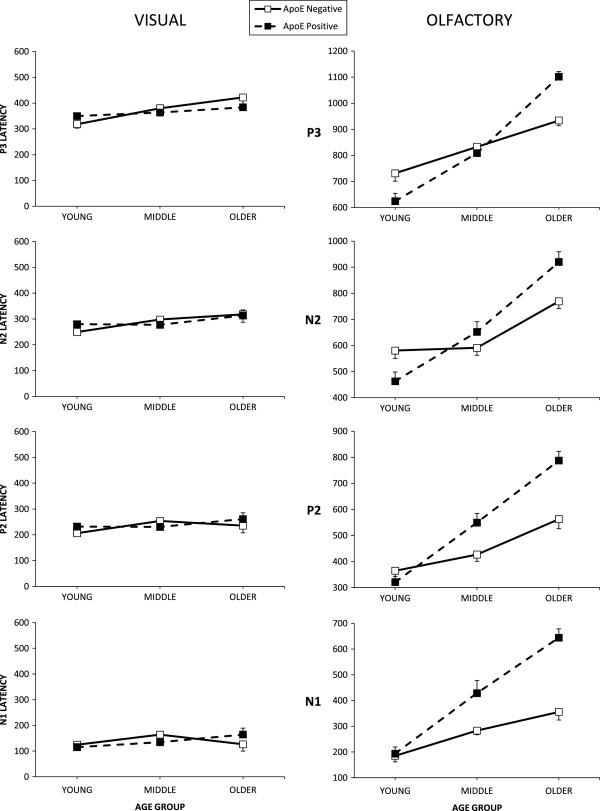
Visual and olfactory average N1, P2, N2, and P3 latencies by age and ApoE groups. Error bars represent the standard error of the mean (SEM).